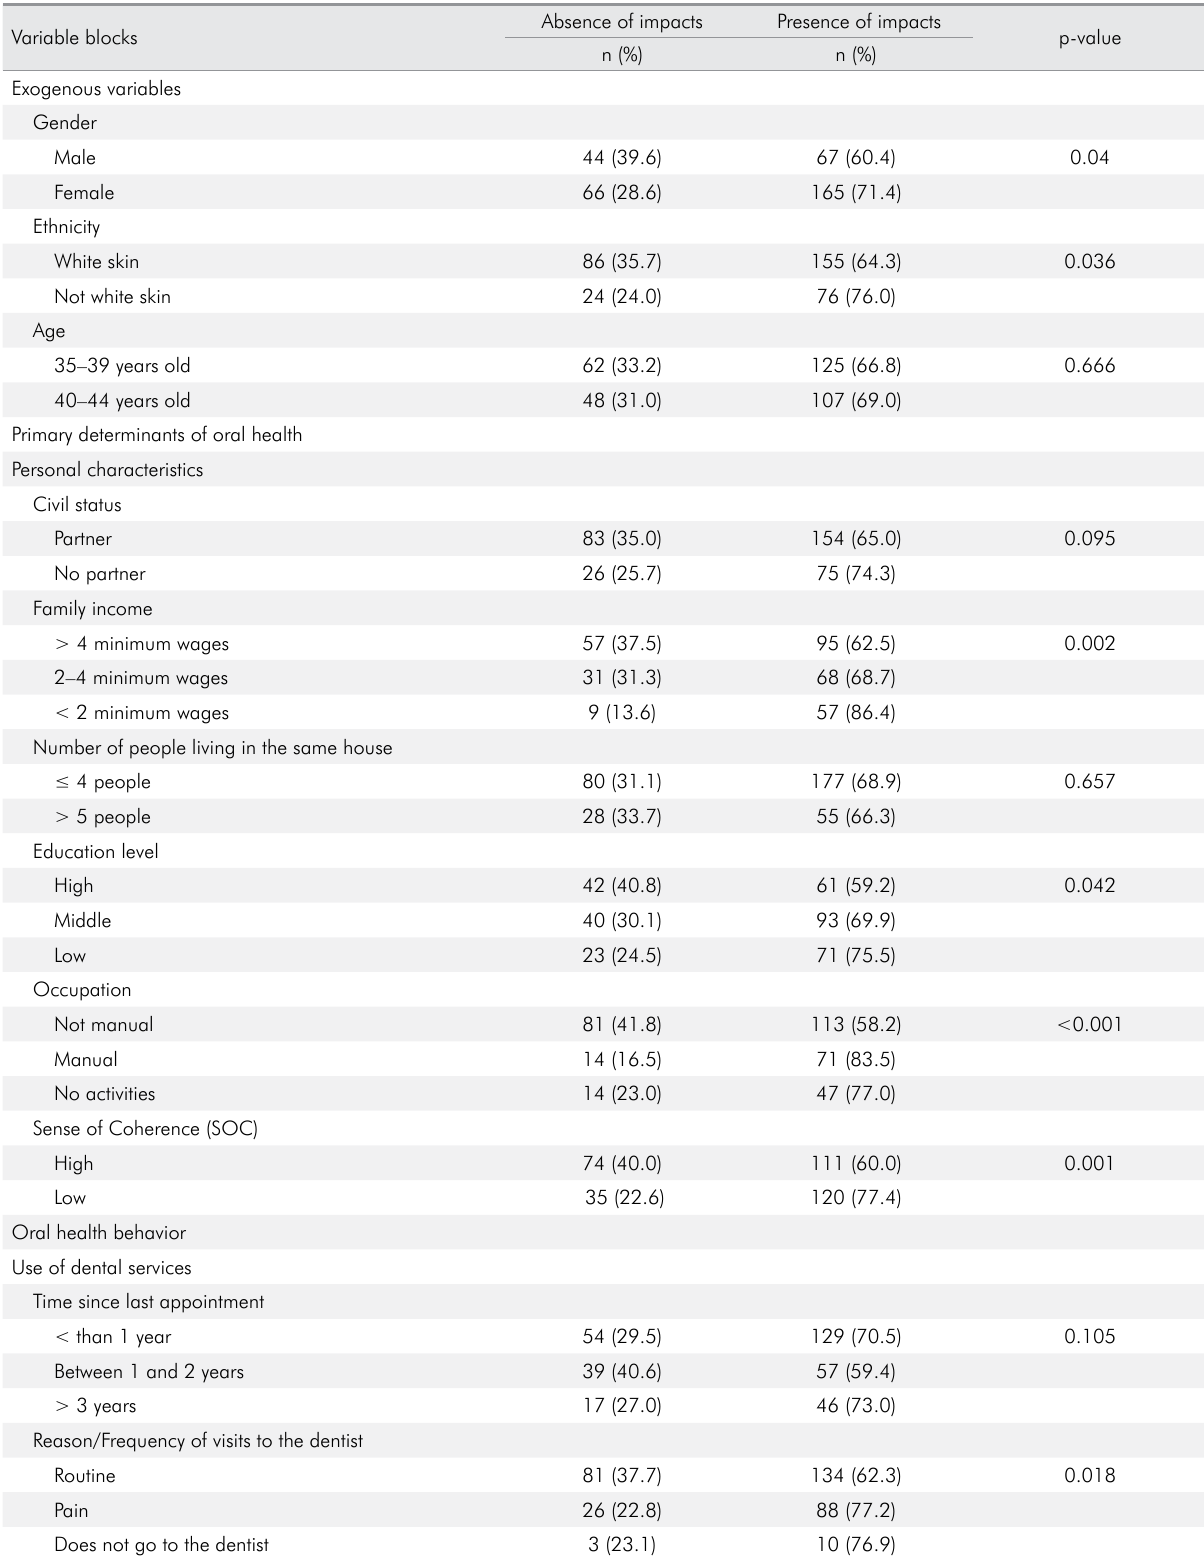
Table 2. Bivariate analyses and p value for presence and absence of impact in adults of Jundiaí, Brazil, 2014. Variable